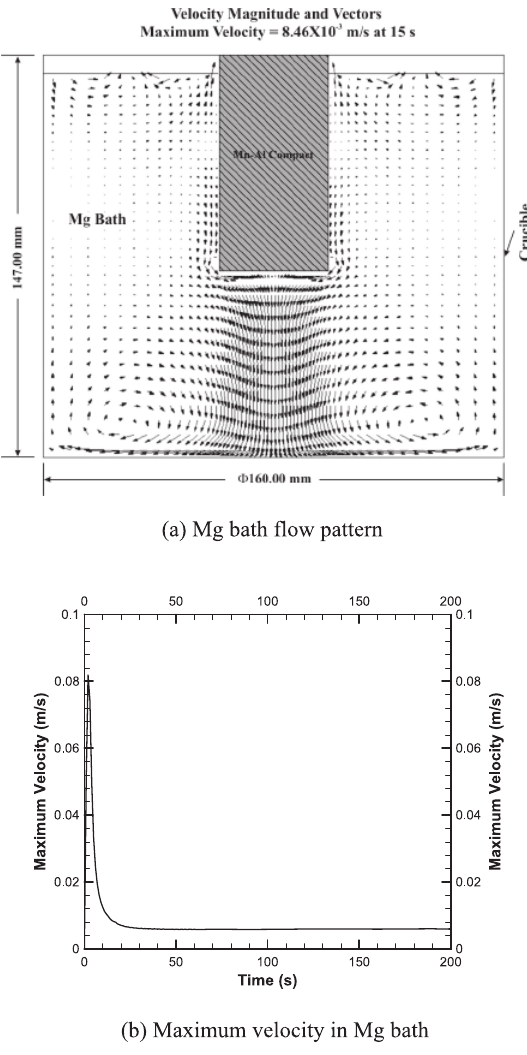
Fig. 6: Simulation results for a Mn-Al compact immersing into Mg